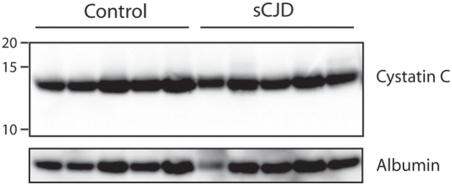
Western blot analysis of cystatin C in the CSF of patients suffering from sCJD.Equivalent amounts of CSF protein (10 µg) from late-stage sCJD patients and from appropriate age-matched non-sCJD patients were fractionated under non-reducing SDS-PAGE conditions and analyzed by Western blot using a polyclonal anti-human cystatin C antibody. No difference was found in CSF cystatin C levels of sCJD patients vs. controls.